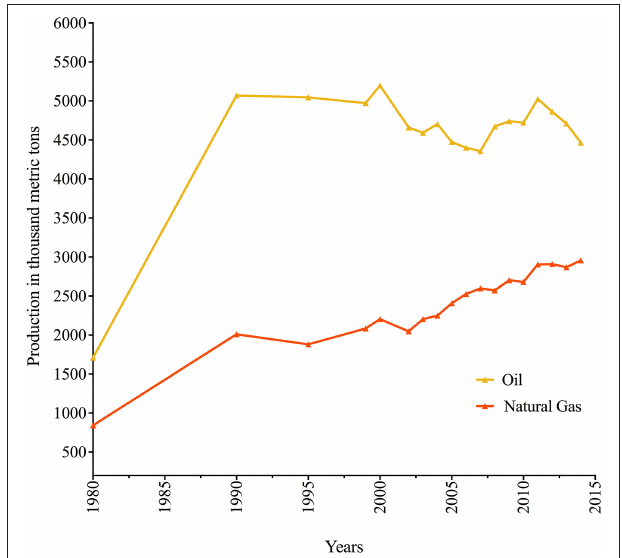
FIGURE 7 | Oil and Gas production in Assam 1980–2014. Data Source: Directorate General of Hydrocarbons, Ministry of Petroleum and Natural Gas, Govt. of India ( Directorate General of Hydrocarbon,